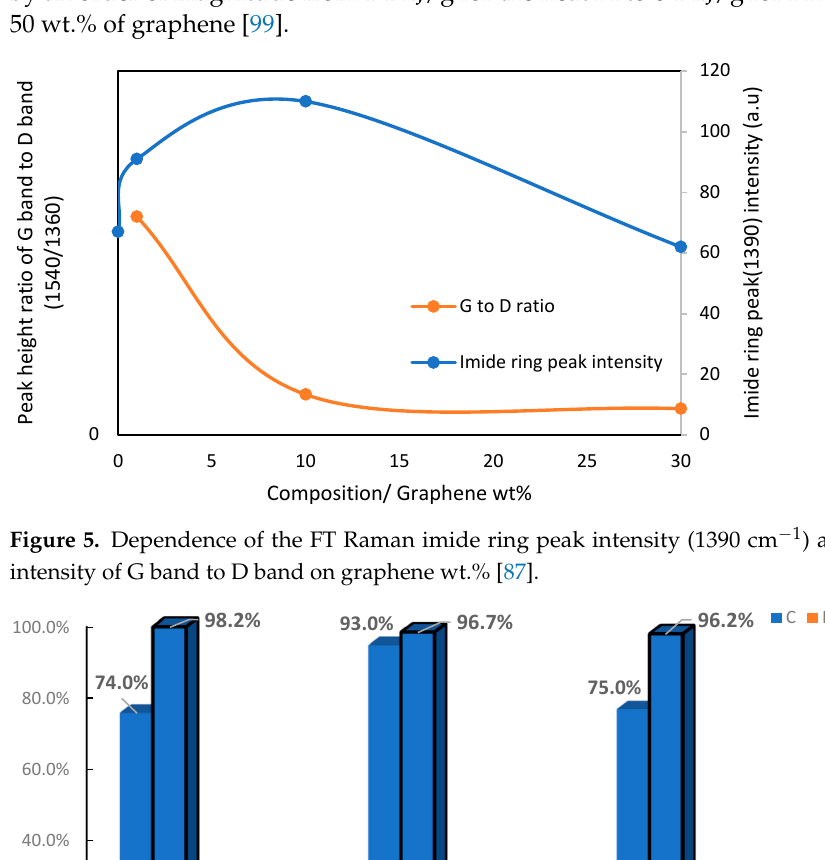
Figure 6. Elemental composition (blue bar: carbon, orange bar: nitrogen, and green bar: oxygen) of PI, graphene and PI/GR (10 wt. %) based on EDAX data (black outline: after combustion) [87,99].